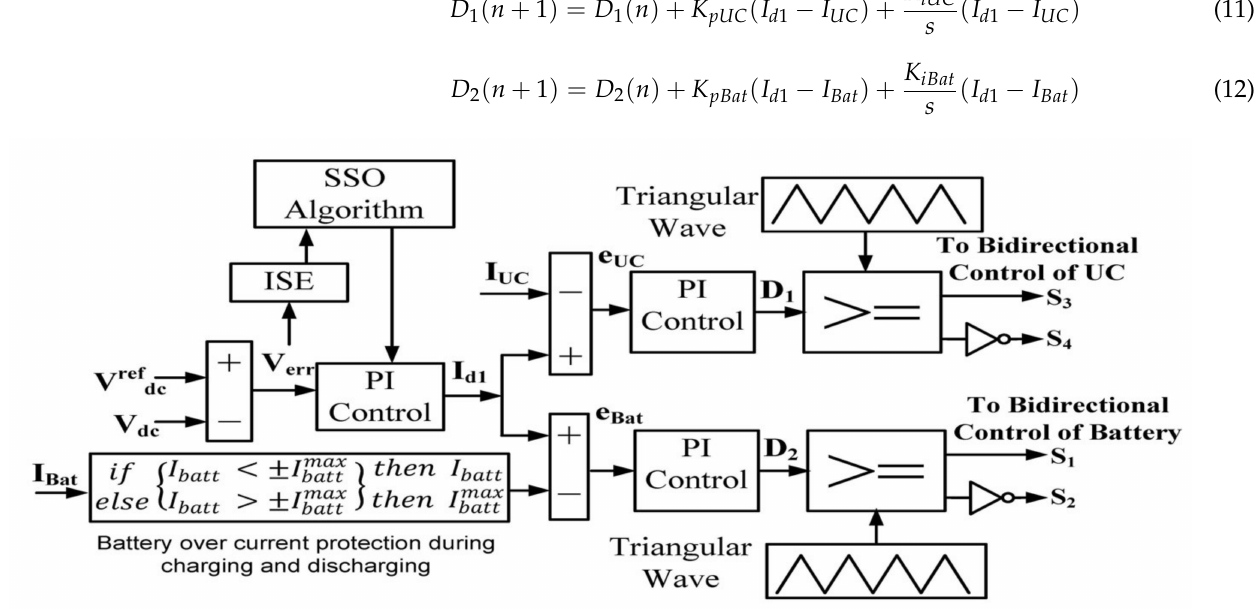
Figure 3. Bi-directional buck-boost converter